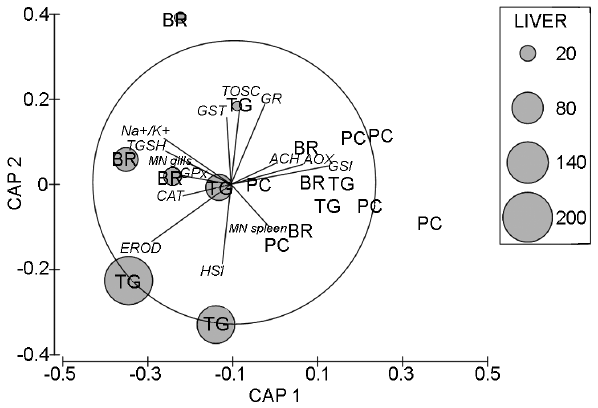
Figure 5. Canonical analysis of principal coordinates for the factor Caulerpin. CAP ordination was obtained from the distance matrix among fish assemblages on the basis of biological responses. Grey circles representing increasing caulerpin concentration in liver were superimposed on each individuals.